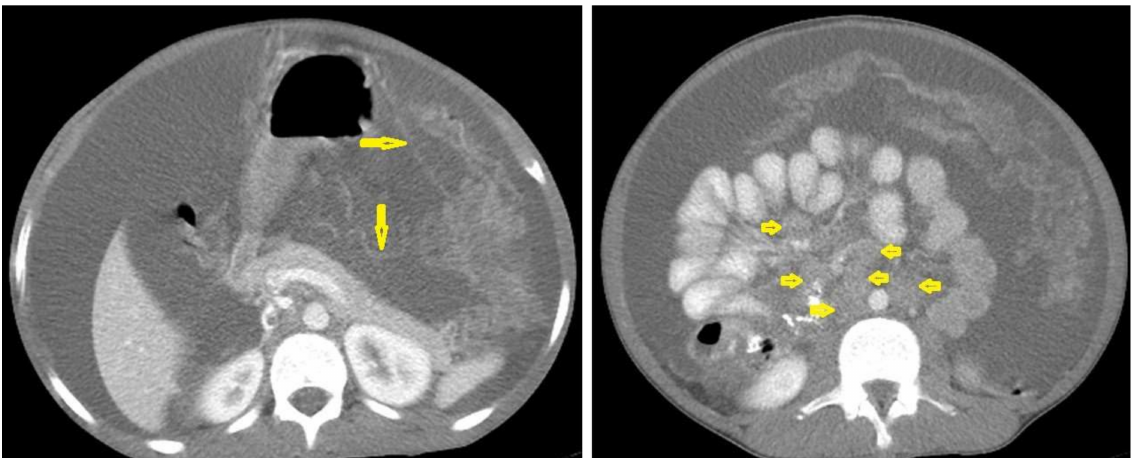
Figure 21. Wet peritonitis in a 16-year-old man with cachexia and loss of appetite. Selected axial abdominal images show marked relatively dense ascites and gross thickened omentum with faint enhancement of peritoneal reflections (long arrows) with multiple enlarged mesenteric and upper paraortic conglomerated lymph nodes (short arrows) with slight homogeneous enhancement.